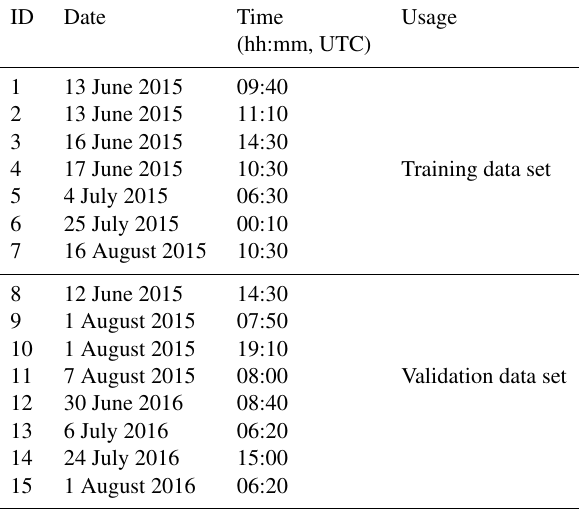
Table 2. Convective initiation (CI) cases used to develop and vali- date the deterministic and probabilistic CI detection